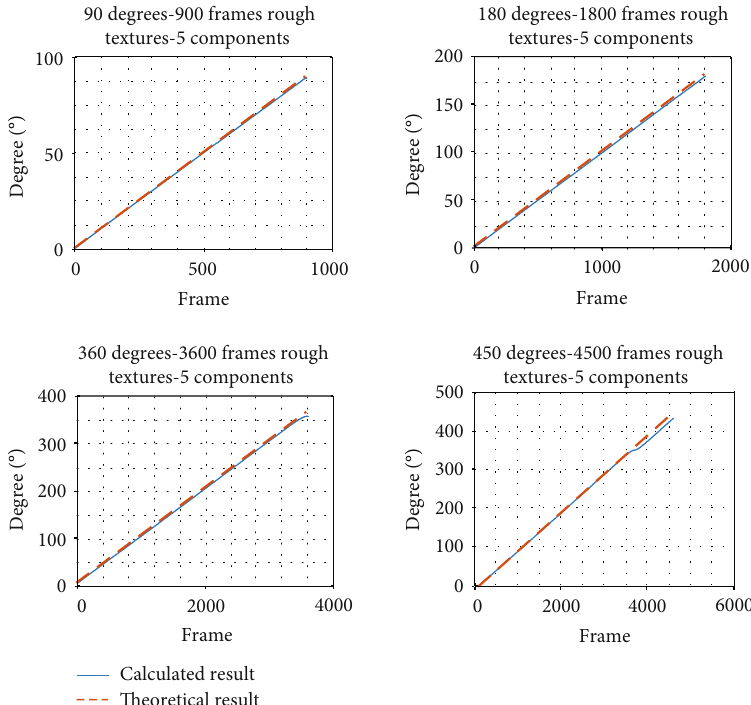
Figure 7: Angle estimation of model (c) under di ff erent rotation angles (10 frames per degree).